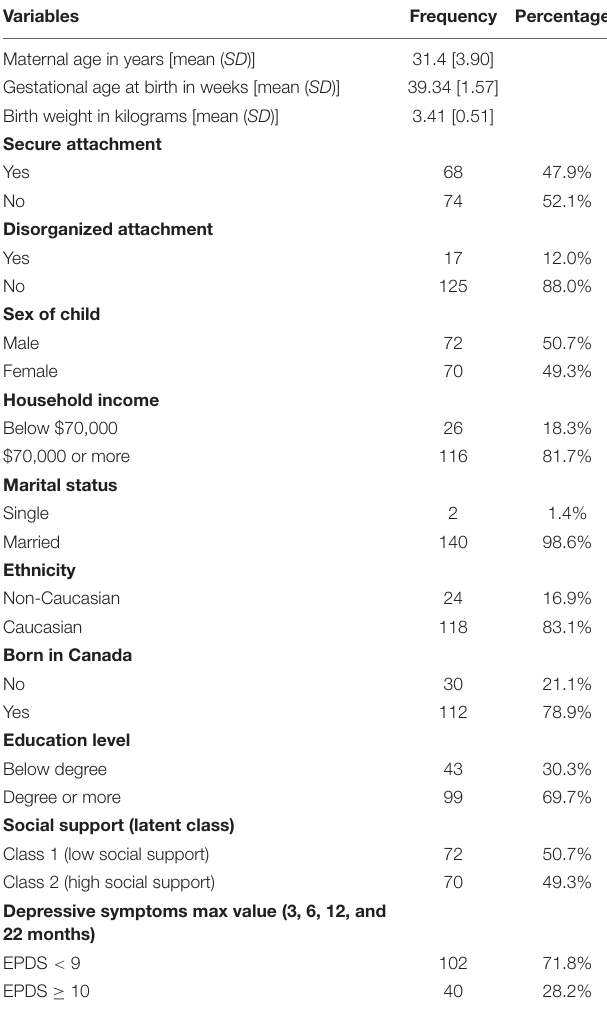
TABLE 1 | Sociodemographic and descriptive characteristics of study